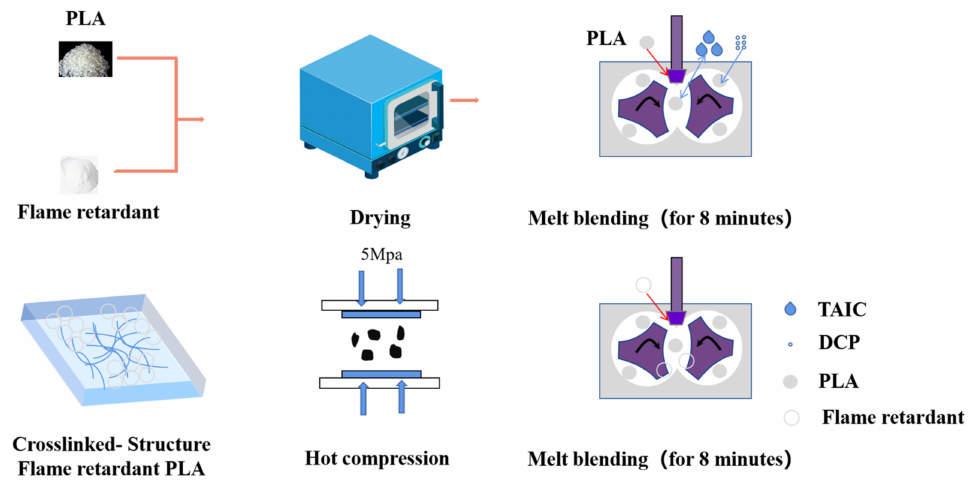
Figure 1. The flow chart of the processing